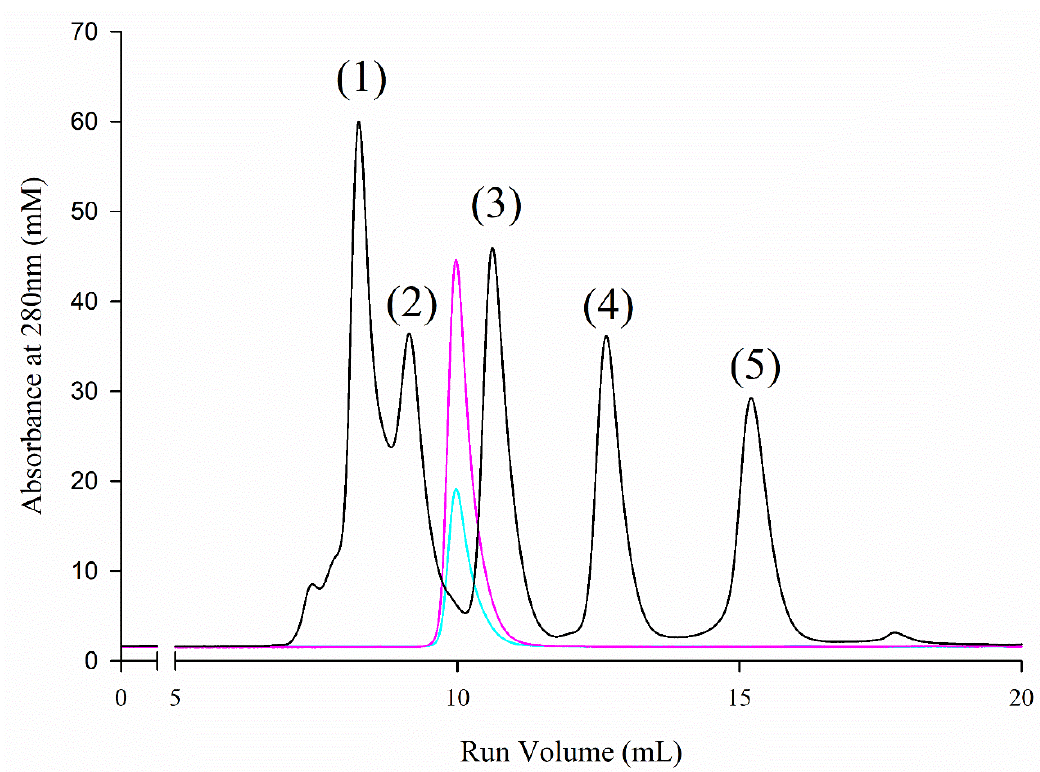
Figure 2. Size-exclusion chromatography of Af LEA1, both by anion-exchange chromatography, obtained fractions of the Af LEA1 (blue: peak fraction 1; magenta: peak fraction 2) elute from a size-exclusion column between ovalbumin (44 kDa) and carbonic anhydrase (29 kDa), respectively. Based on these data, the apparent molecular mass of Af LEA1 computes to 33.4 kDa, or approximately 75% larger than the calculated mass based on the polypeptide sequence of the protein. The black line shows the elution of molecular weight markers. The elution maxima correspond to: (1) conalbumin, 75 kDa; (2) ovalbumin, 44 kDa; (3) carbonic anhydrase, 29 kDa; (4) ribonuclease A, 13.7 kDa; and (5) aprotinin 6.5 kDa.